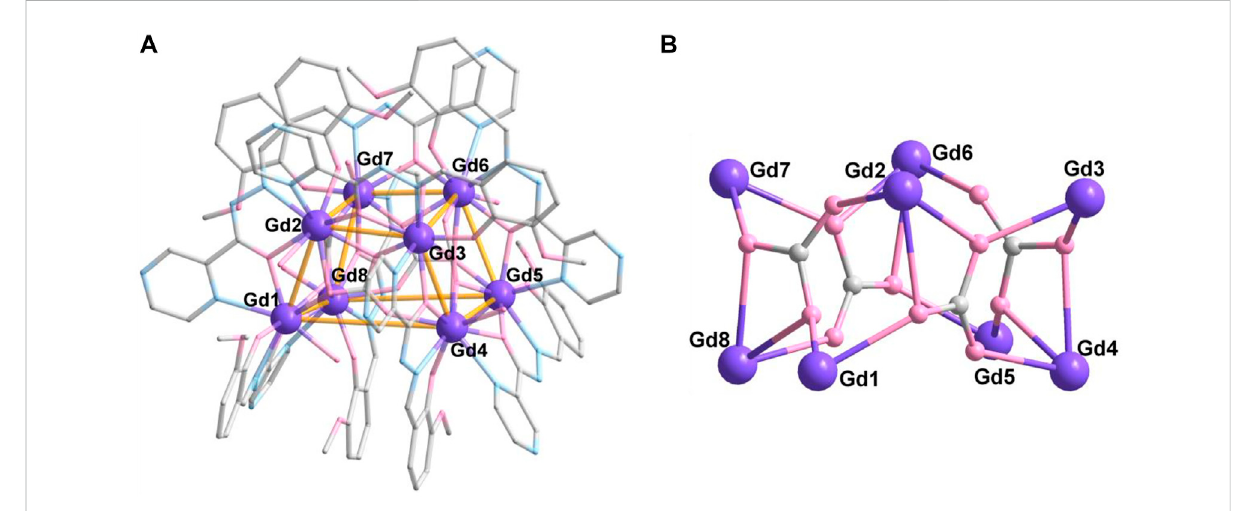
FIGURE 3 Crystalstructure (A) andmetalliccore (B) of 3